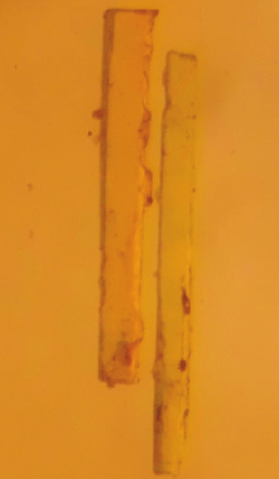
Figure 7: Images of the growth morphologies of 2C 13 H 12 N 2 O ⋅ H 2